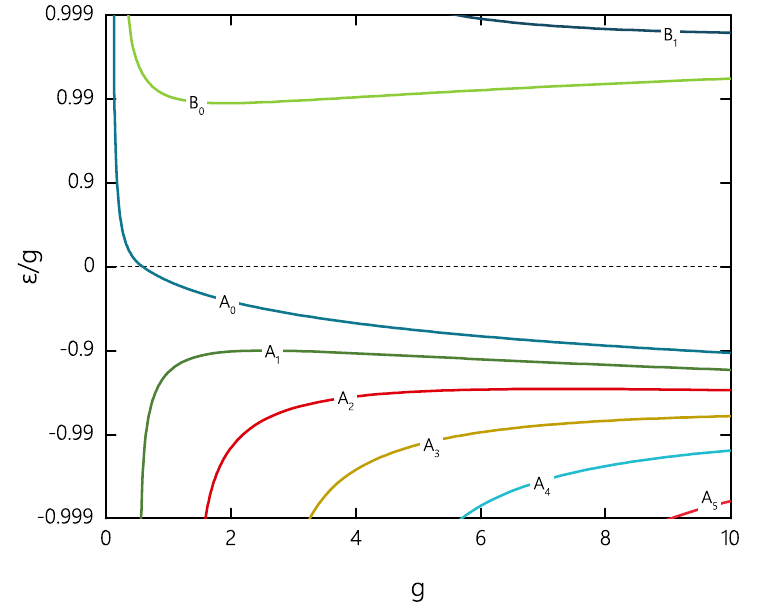
Figure 1 . Normalized energy ε of the localized fermionic states as a function of the fermion- g Skyrmion coupling g for several fermion modes at m = 0 and κ 0 = 0 .